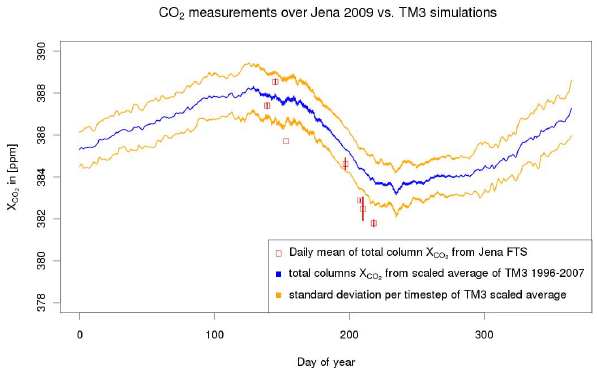
Fig. 16. Total column X CO measurements over Jena vs. extrapo- 2 lated TM3 results for 2009. Empty red boxes represent individual X CO measurements from the FTIR. Red boxes with vertical lines 2 represent daily mean values of X CO with error bars (vertical lines). Fig. 17. Footprint analysis for a total-column instrument on Ascen- 2 sion Island. The coloured values represent the relative contribution to the total column for different surface regions in arbitrary units that have been normalized to 100 at the peak value. The footprint was produced using the TM3 adjoint by R¨odenbeck (2005) at a hor- izontal resolution of 5 ◦ × 3.75 ◦ . Individual runs for each month of 2006 were integrated to provide this full-year